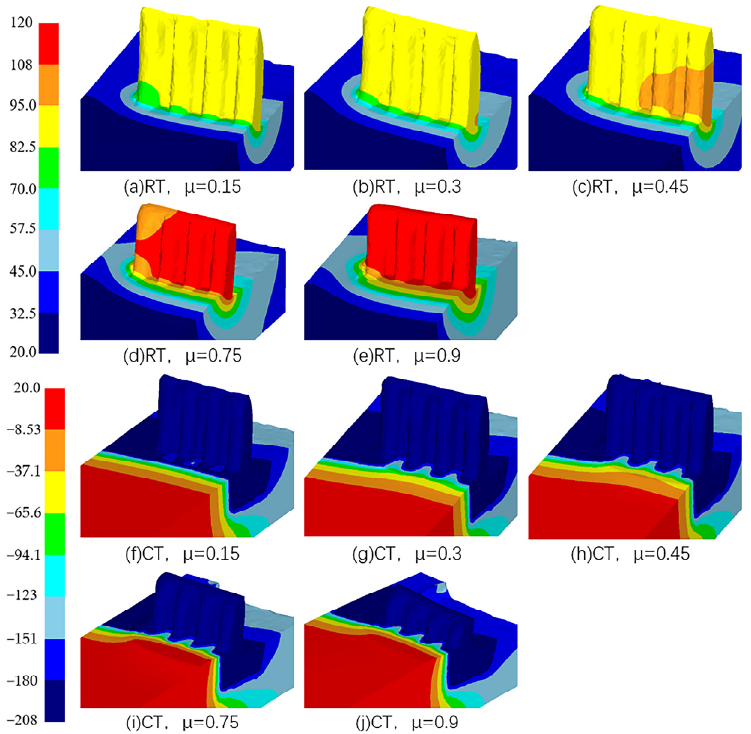
Figure 18. Temperature distribution of the fins under different conditions.